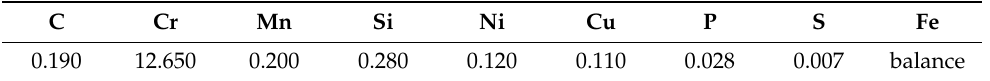
Table 1. Chemical composition of AISI 420 martensitic stainless steel